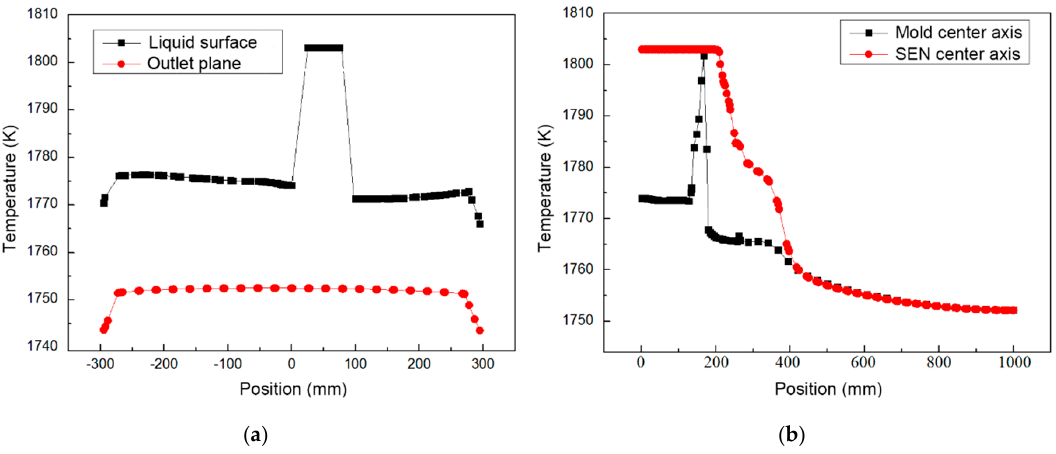
Figure 19. Temperature field of the mold with the optimized swirling SEN. ( a ) The temperature distribution along radial direction; ( b ) The temperature distribution along the center line.